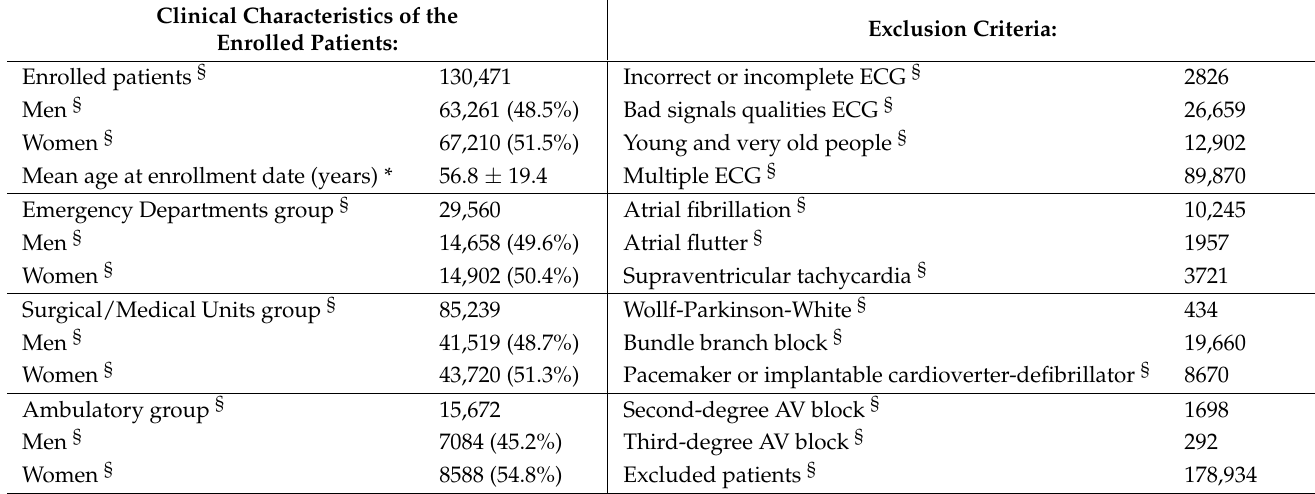
Table 1. Baseline characteristics of the study population and exclusion